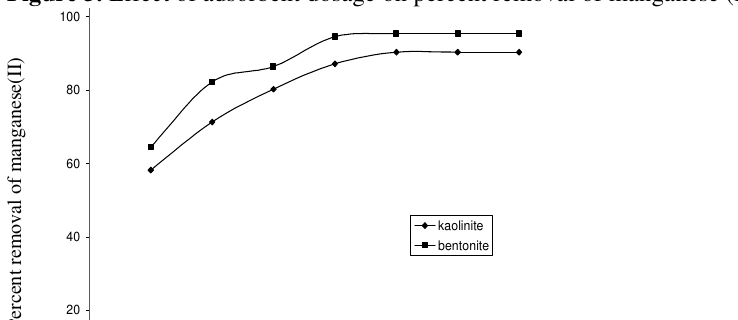
Figure 3. Effect of adsorbent dosage on percent removal of manganese (II)